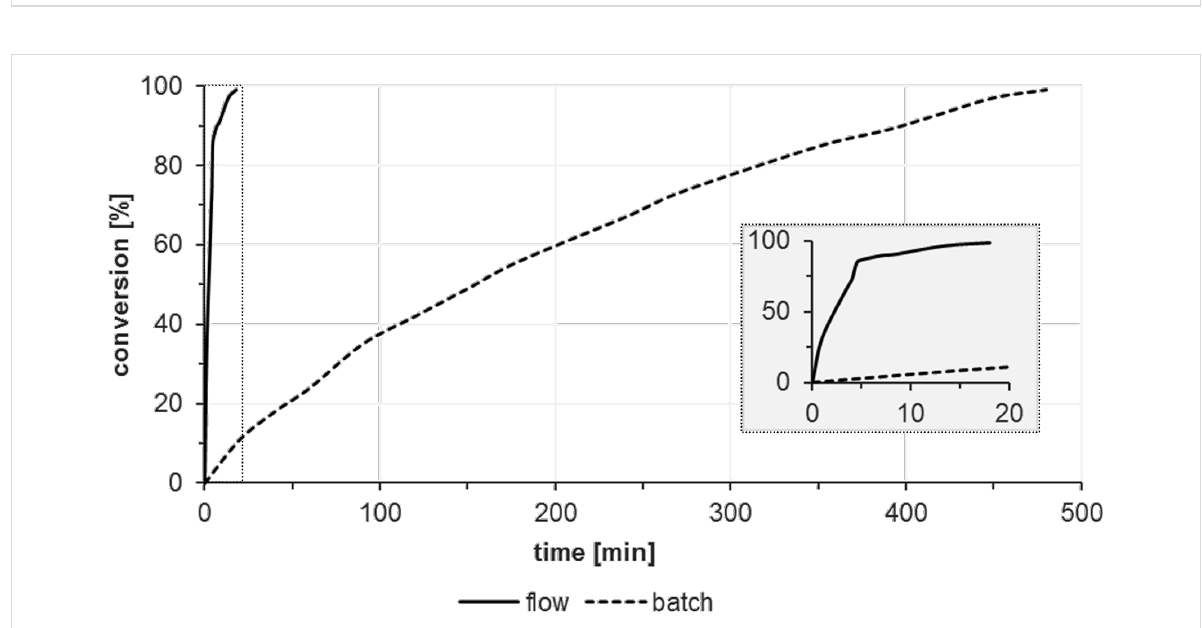
Figure 9: Reaction progress at different residence times in flow and batch reactions. Flow: reactions at different flow rates in MeCN at 10 °C; 0.01 M 1a , 1 mM methylene blue, 2.4 bar, irradiation by Osram Dulux Superstar. Batch: 0.05 M 1a , 0.1 mM methylene blue in MeCN at rt, irradiation by warm white LEDs.